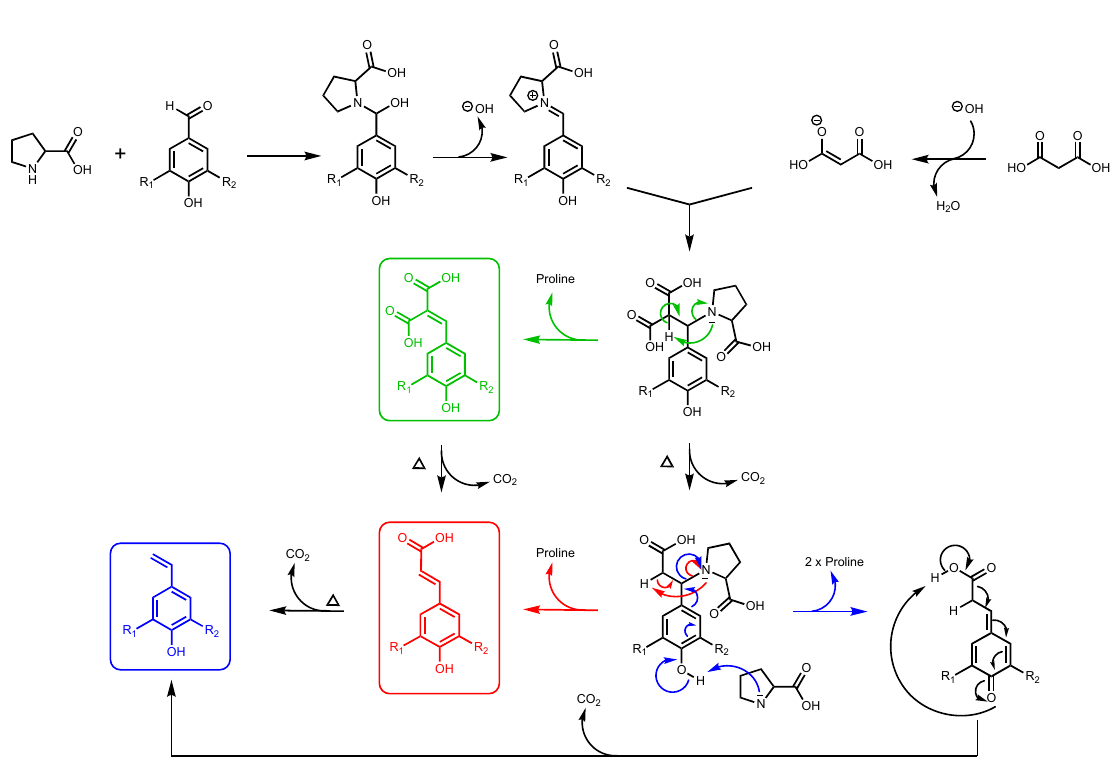
Figure 2. Formation of p -hydroxycinnamic diacids, p -hydroxycinnamic acids, and the corresponding